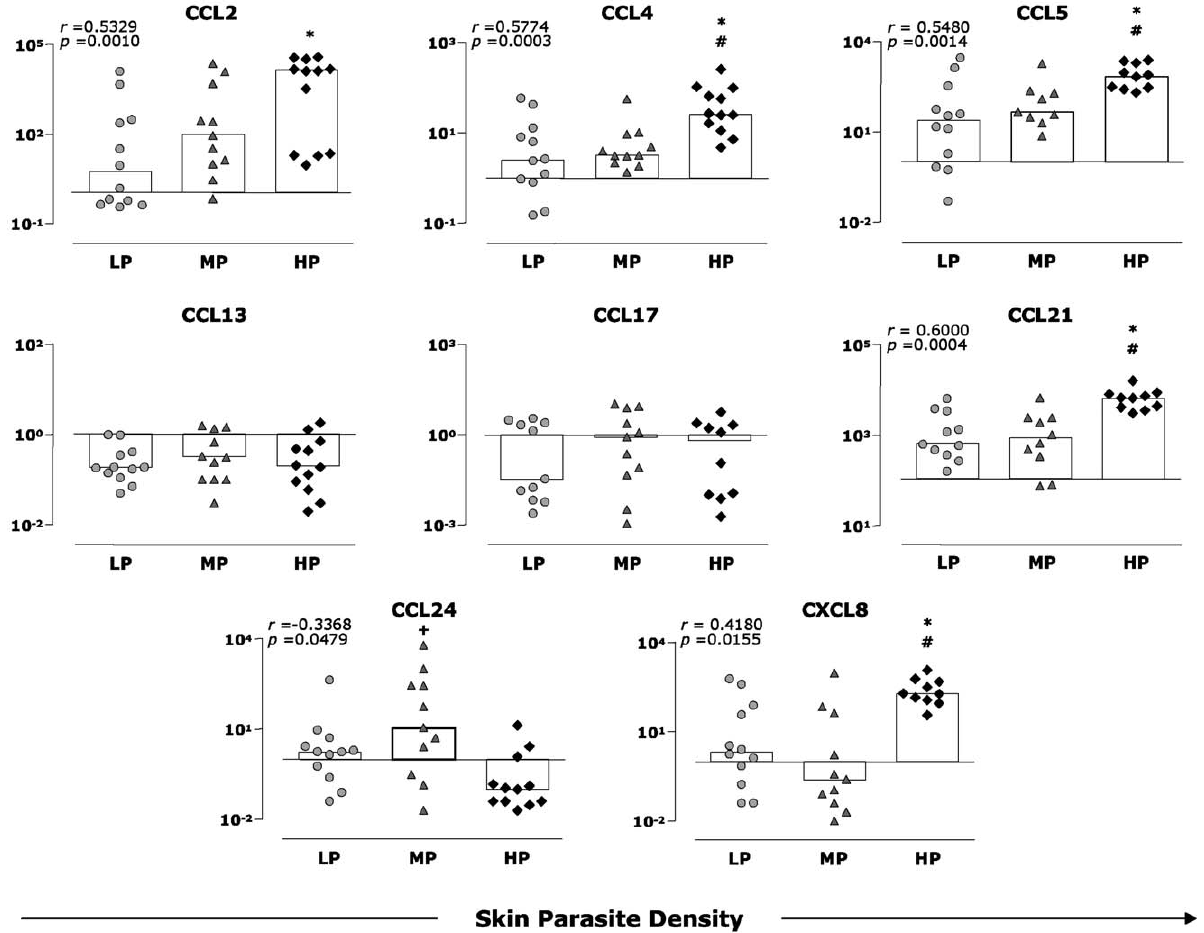
Figure 3. Skin parasite density and expression of chemokines in the skin from dogs with L.infantum . Animals were categorized according to their skin parasite density into low (LP=gray circles), medium (MP=gray triangles), and high (HP=dark diamonds) parasite load. The results are expressed as scattering of individual values and median of that group (bars) of log 10 of the relative copy number of mRNA for CCL2, CCL4, CCL5, CCL13, CCL17, CCL21, CCL24, and CXCL8. Significant differences ( p , 0.05) compared with LP, MP, and HP are indicated by the symbols *, # , and + , respectively. Spearman’s correlation indexes ( r and p values) are shown on the graphs when applicable.